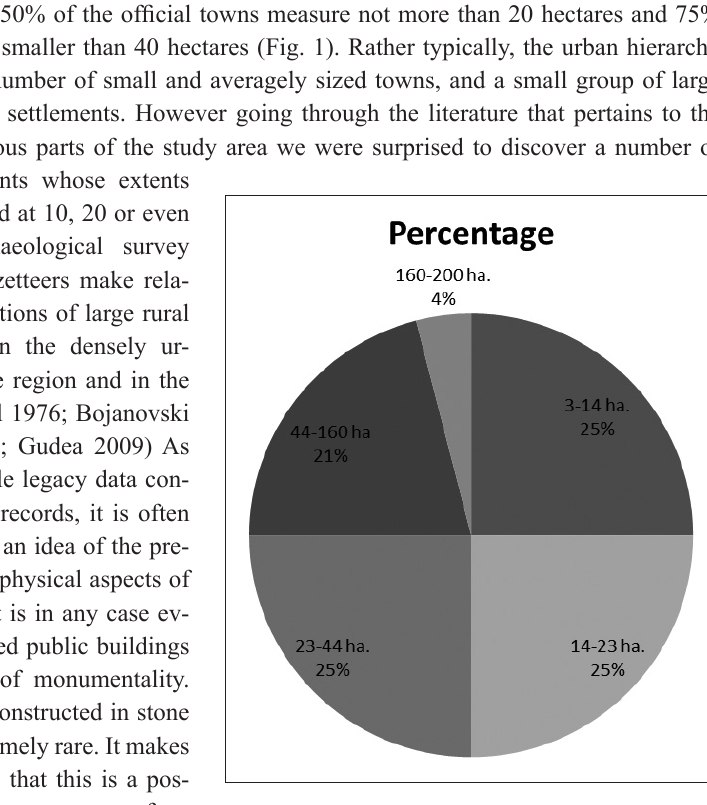
Figure 1: The distribution of the autonomous towns by maximum built-up area, in